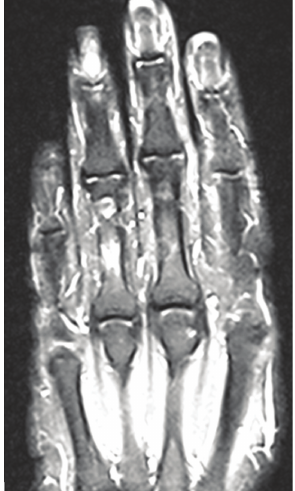
Figure 1: MRI of right hand showing glomus tumor of 4th